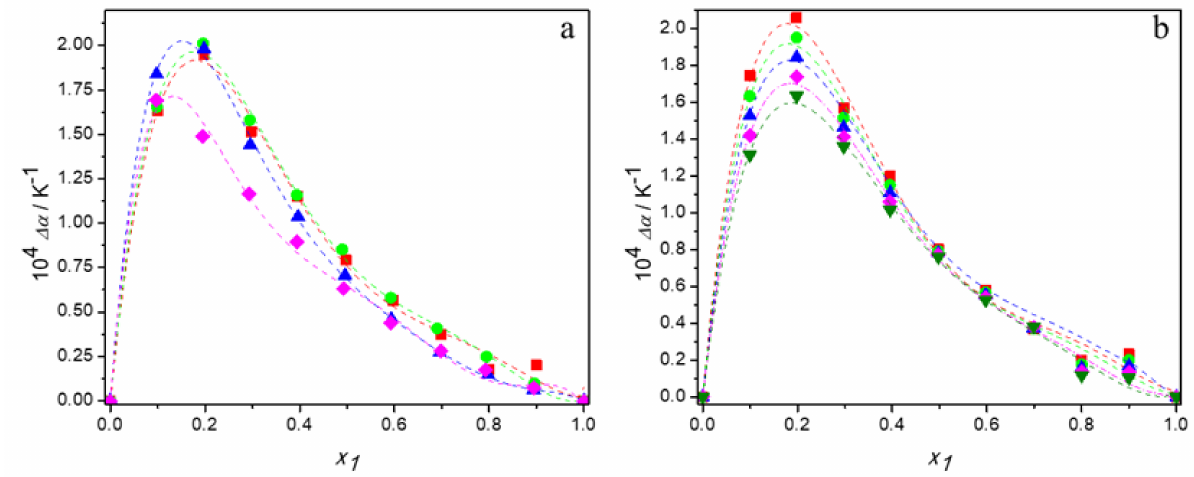
Figure 5. Dependence of the excess thermal expansion of aqueous solutions of DESs on molar fraction of deep eutectic solvent: ( a ) at 298.15 K for (cid:4) DES1; • DES2; (cid:78) DES3; (cid:7) DES4; ( b ) for DES1 at 293.15 K ( (cid:4) ); 298.15 K ( • ); 303.15 K ( (cid:78) ); 308.15 K ( (cid:7) ); 313.15 K ( (cid:72) ); —, Equation